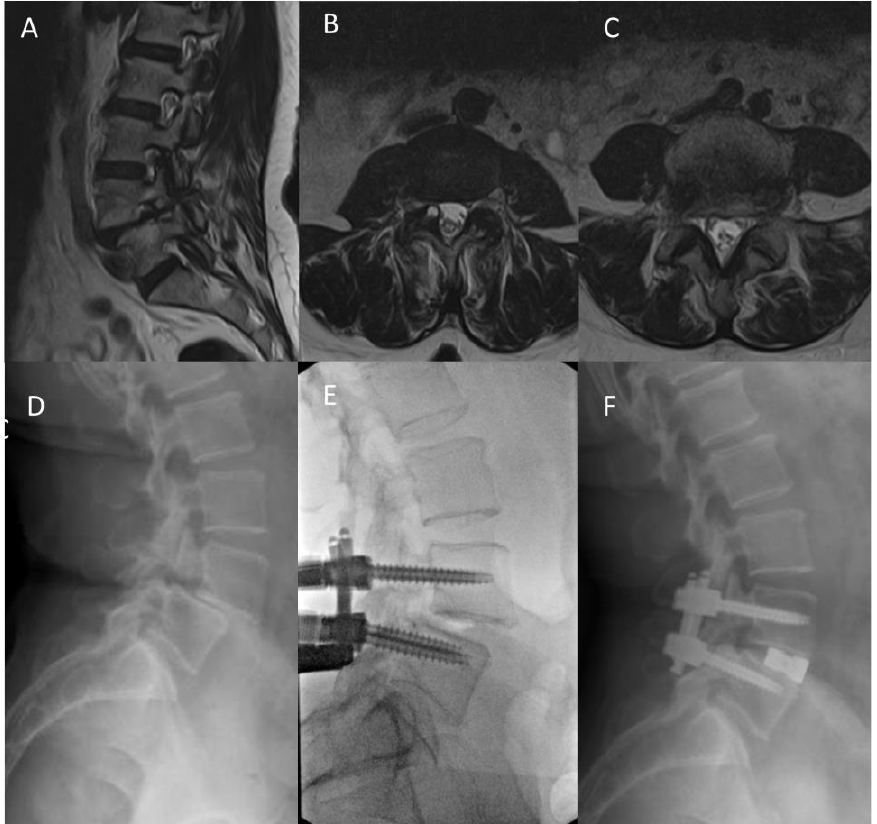
Figure 1. Case 1: ( A ) parasagittal T2 MRI image demonstrating severe foraminal stenosis; ( B ) axial T2 MRI image of L3 – 4 demonstrating rt facet cyst; ( C ) axial T2 MRI image of L4 – 5 demonstrating foraminal stenosis; ( D ) preoperative lateral X-ray demonstrating grade-2 lytic spondylolisthesis at L4 – 5; ( E ) intraoperative fluoroscopy demonstrating partial reduction following posterior